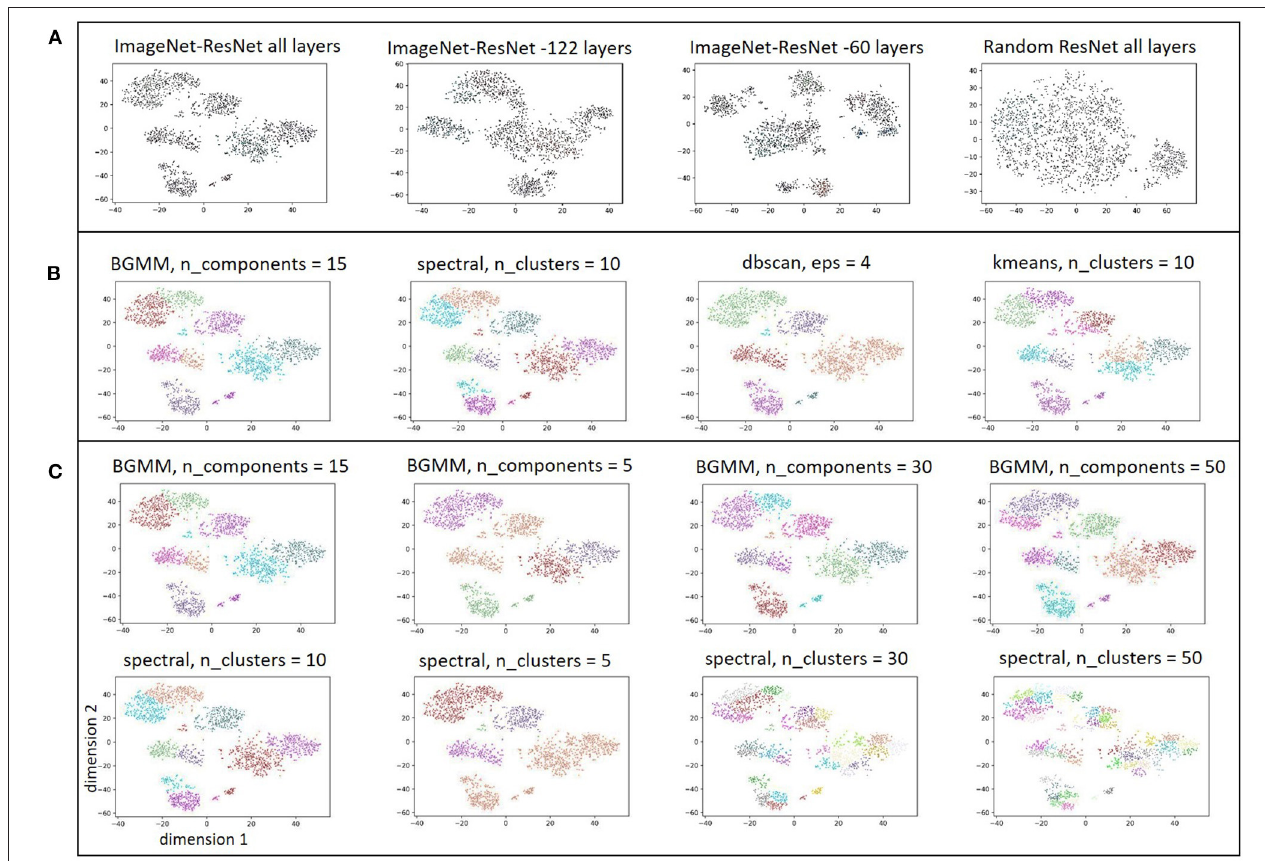
FIGURE 7 | (A) Embedding of iEEG records in one patient with feature maps extracted by ImageNet-ResNet model containing all layers, ImageNet-ResNet with 122 layers removed from the end, ImageNet-ResNet with 60 layers removed from the end, and a ResNet50 model with randomly initialized weights. (B) Comparison of clusters identified by BGMM method with input parameter, n_components, set to 15, spectral clustering method with n_clusters set to 10, dbscan with epsilon set to 4, and kmeans with n_clusters set to 10. (C) Comparison of clusters identified by BGMM method with a range of input parameter values (n_components = 15,5,30,50) and spectral clustering method with n_clusters = 10,5,30,50. Note that spectral clustering here does not refer to clustering with hand-engineered spectral power features as discussed in Figure 6 , rather it refers to a clustering method that uses a normalized Laplacian (see sklearn.cluster.spectralclustering).